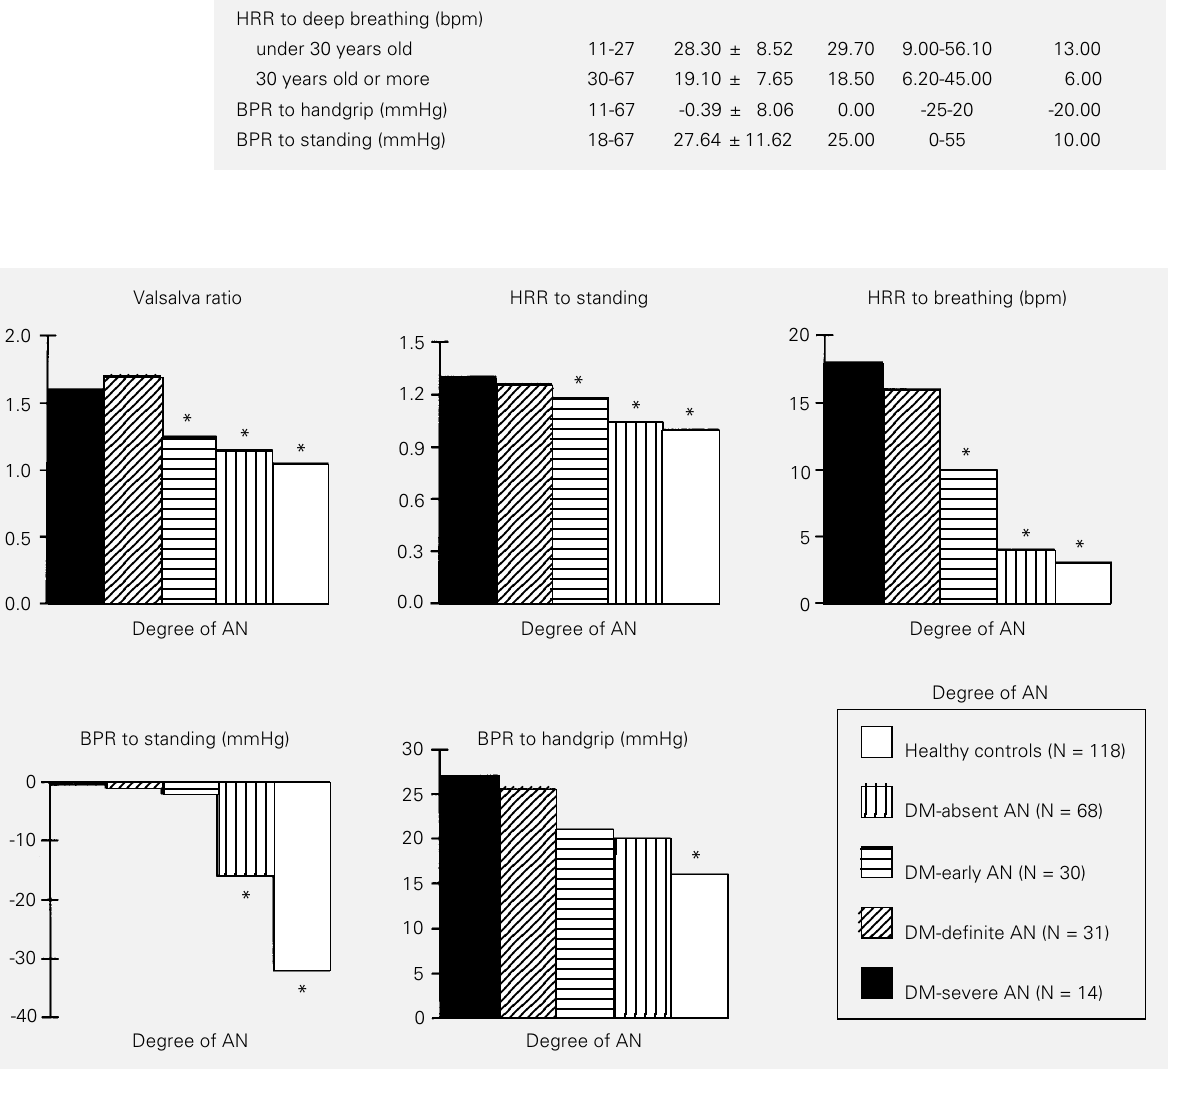
Figure 3 - Responses to cardiovascular tests by healthy controls and diabetic patients with different degrees of autonomic neuropathy (AN). For the deep breathing test, data for persons older than 29 years are reported. The number of persons in each group is given in parentheses. Responses were calculated using the computerized method. HRR, Heart rate response; BPR, blood pressure response. *P<0.05 (Kruskal Wallis one-way analysis of